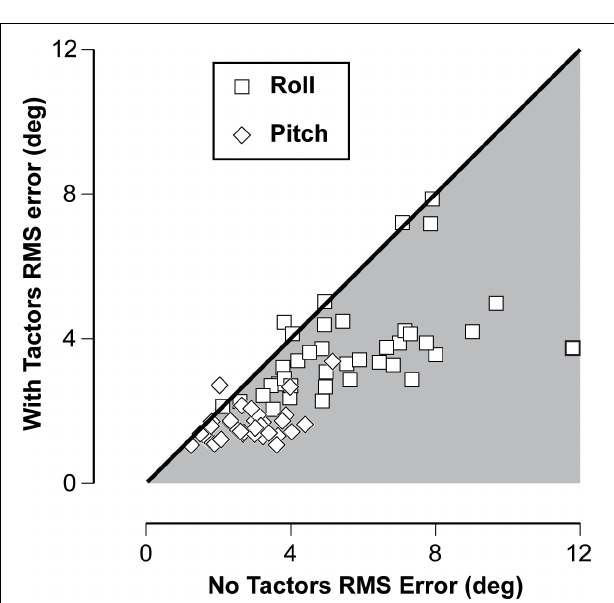
FIGURE 4 | Plot of RMS error values with and without vibrotactile feedback in both the roll and pitch tilt and across all test days for each of the 11 subjects. The unity line illustrates when performance is the same with and without vibrotactile feedback, while the shaded region below this line indicates when performance is improved (RMS error is reduced) with vibrotactile